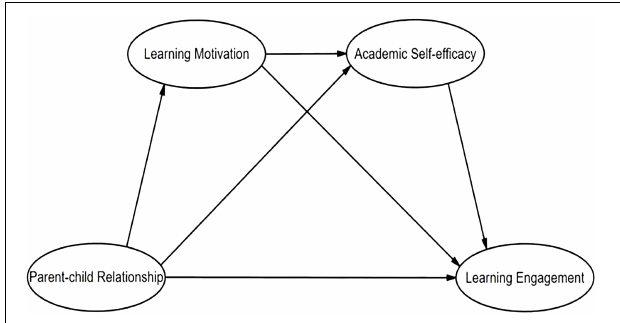
FIGURE 1 | The proposed theoretical